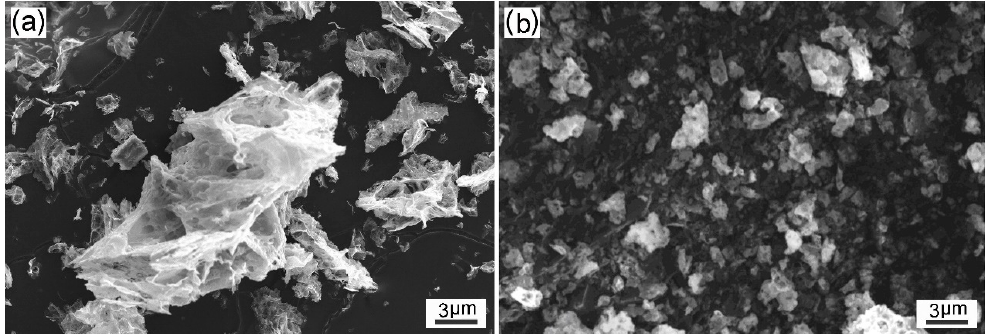
Figure 3. SEM images of the combusted powder synthesized in different media: ( a ) water; ( b ) alcohol.